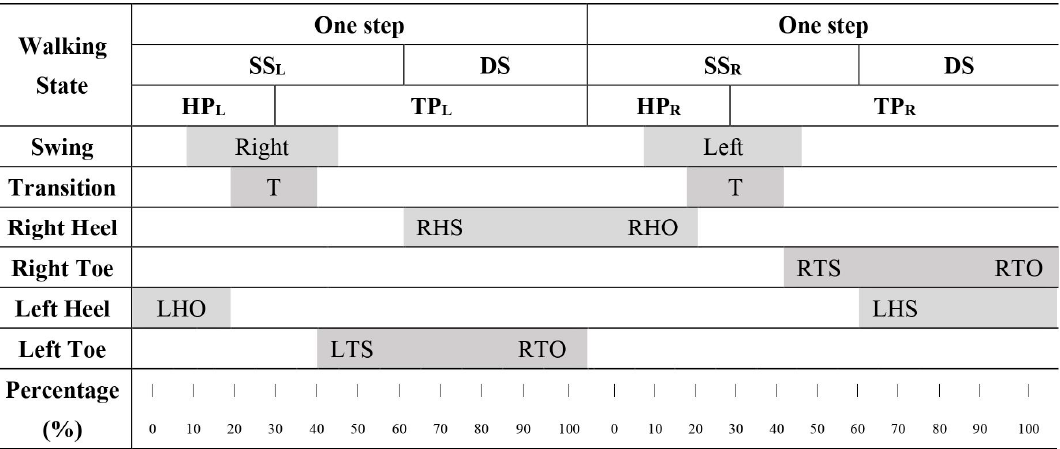
Figure 9. Walking state in two steps: one step is indicated as being from 0 to 100%.